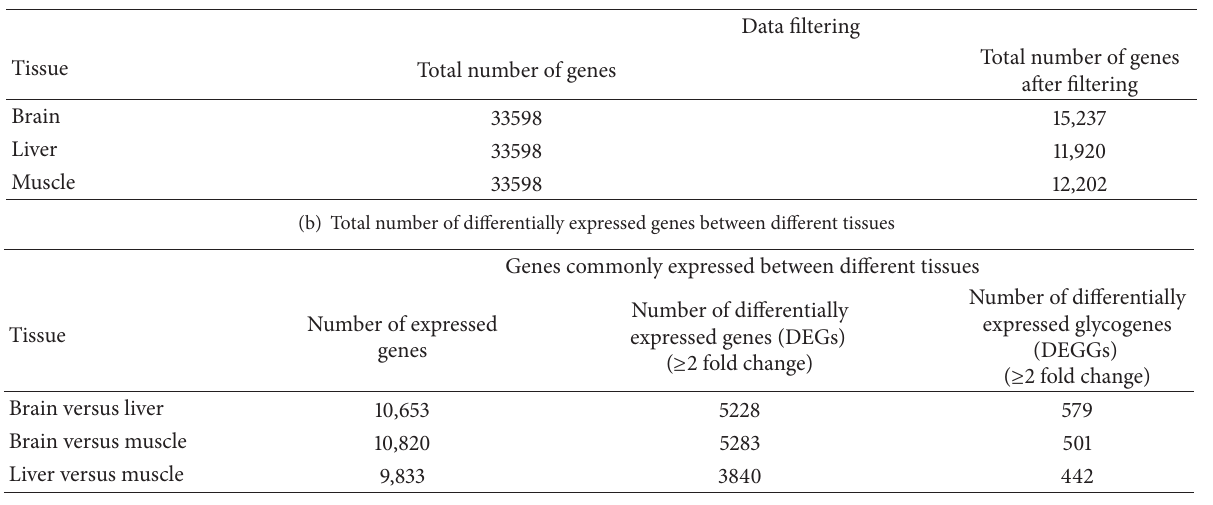
Table 1: Gene expression